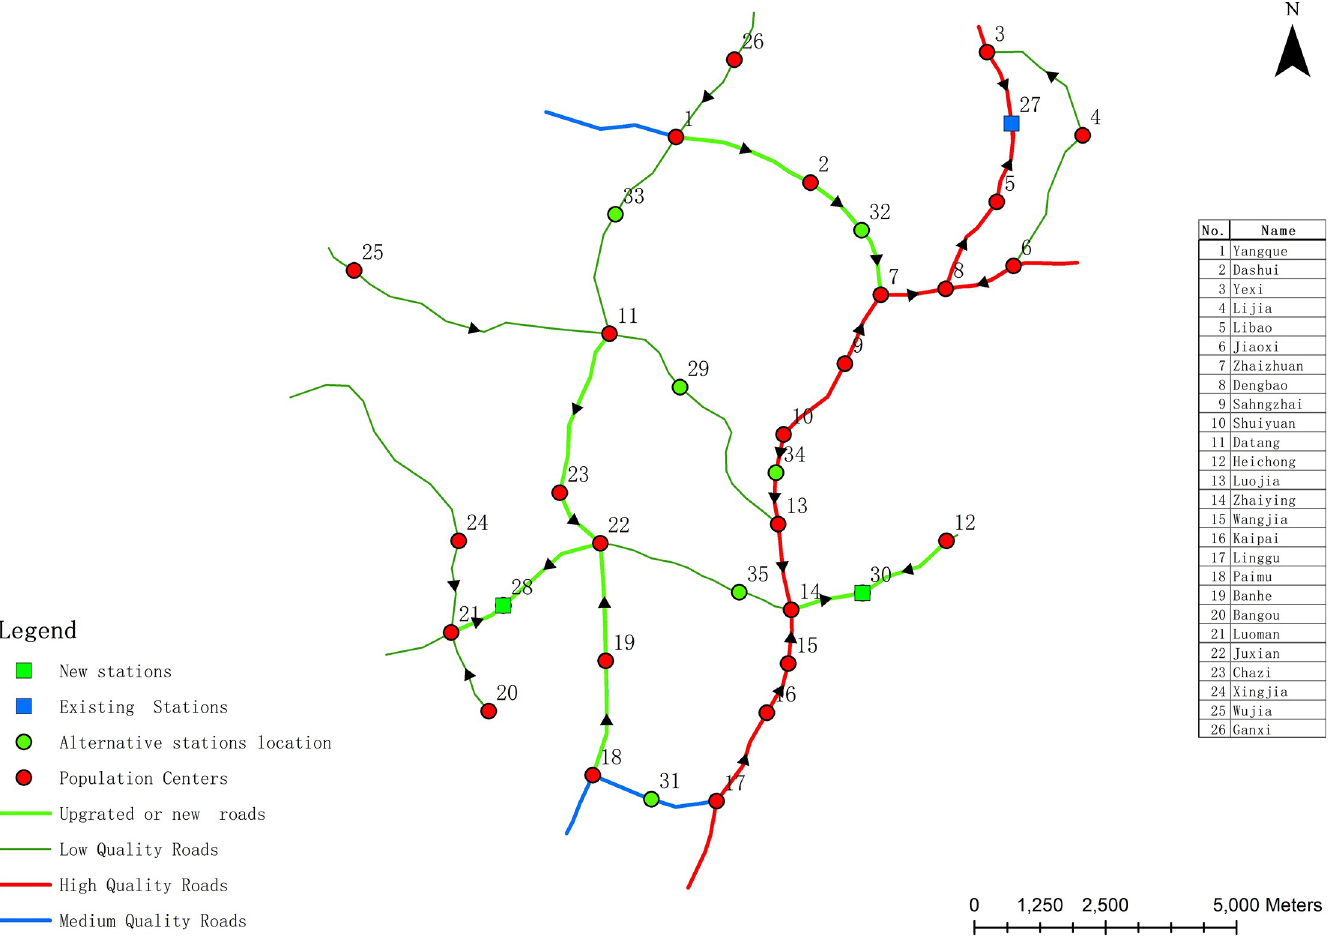
Fig 8. Waste transfer station layout and road upgrading results of scheme #24 under Model 3.